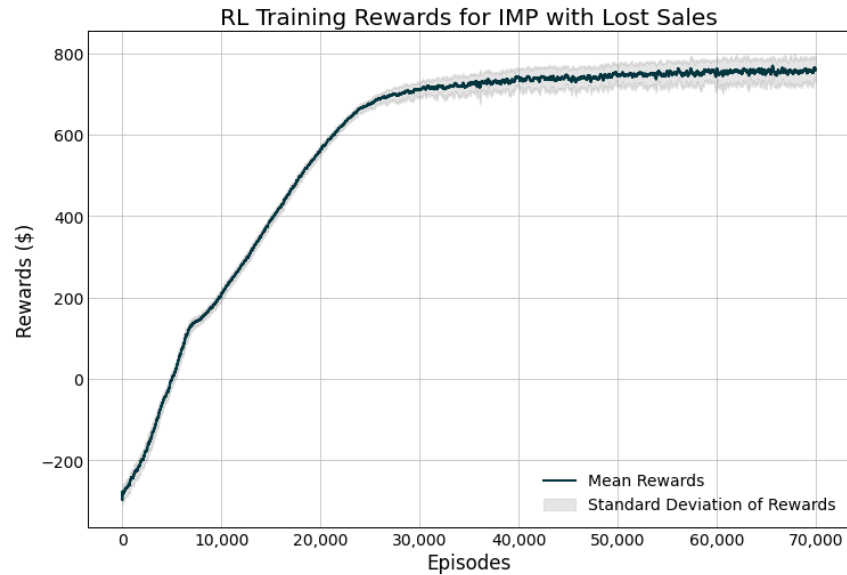
Figure 4. Training curve for the reinforcement learning (RL)